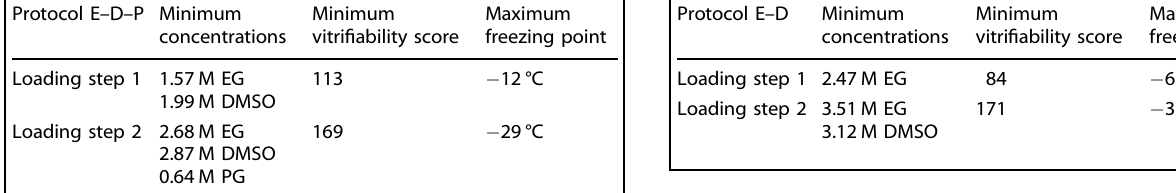
solution in 50-mL Falcon tubes. Then, two 2-step cryoprotectant loading protocols (Protocol E – D – P and Protocol E – D in Fig. 1b) with calculated loading times and preset temperatures at each step were followed to load suf fi cient amounts of cryoprotectants into the cartilage cubes. After the cryoprotectant permeation procedure, the particulated cartilage cubes were quickly removed